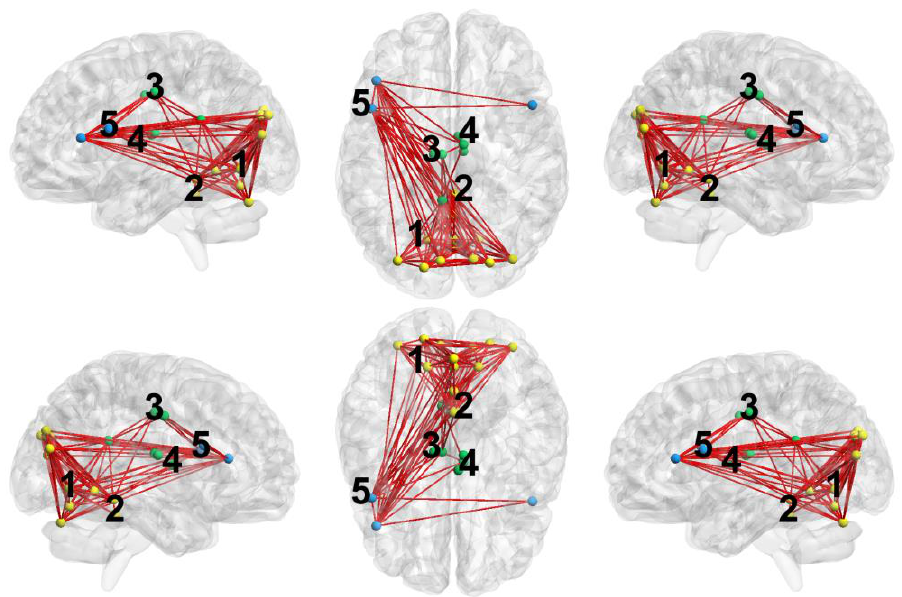
Figure 2. Connected graph obtained for the significant positive clusters (Control > MDE) of the considered network measures. Dots correspond to the nodes of the clusters and lines correspond to the significant connections between the nodes. Numbers denote approximate positions of the clusters (see Table 3). Yellow clusters are similar for all considered network measures; green clusters are similar for eigenvector centrality and node strength; blue clusters are unique for eigenvector centrality.